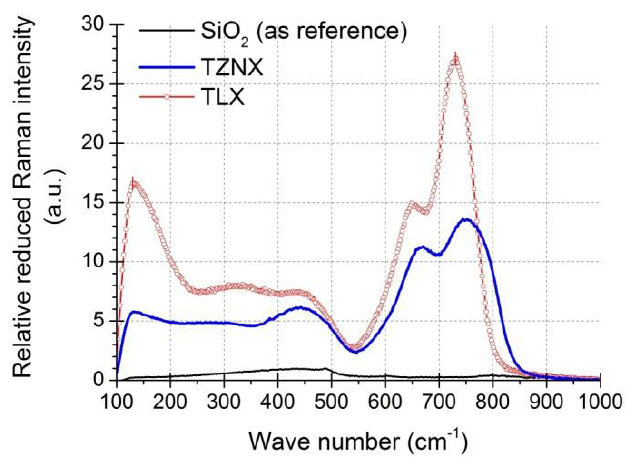
Figure 7. Relative reduced Raman intensities of studied tellurite glasses and referenced pure silica glass, normalized to the peak intensity of silica at 440 cm −1